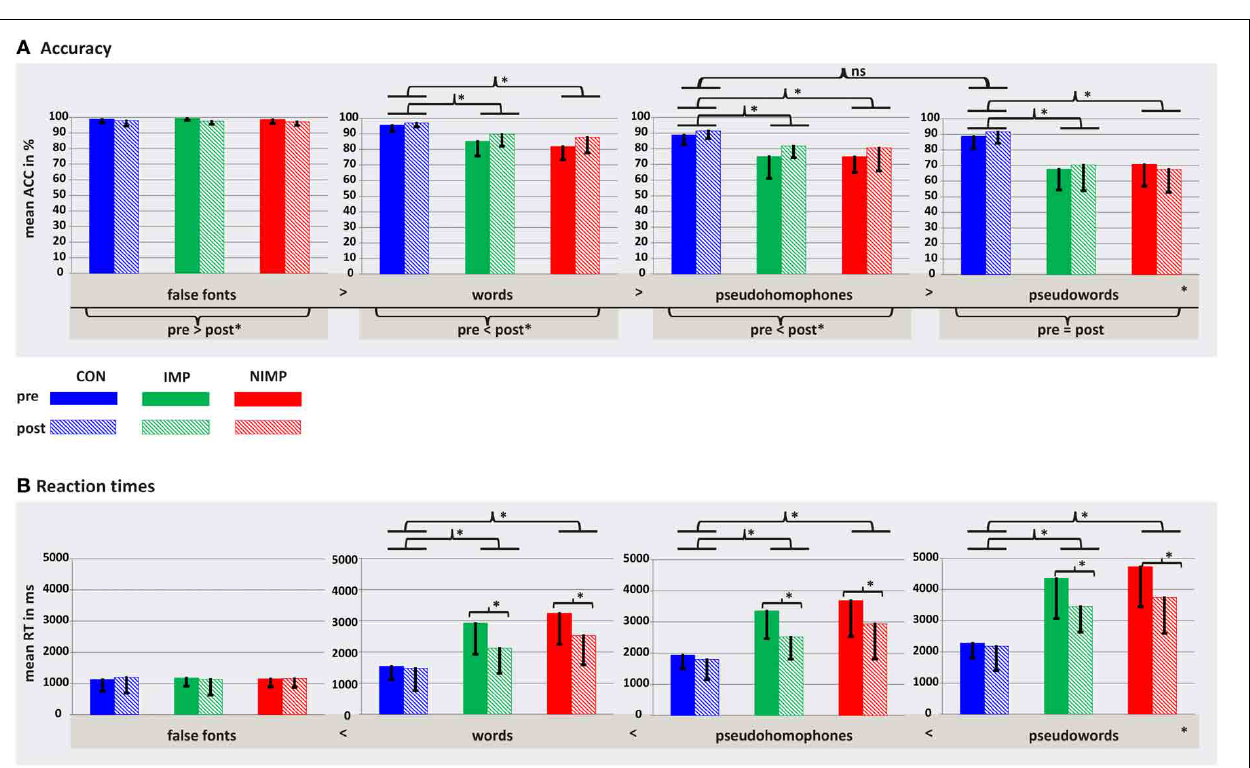
in common word reading fluency and N400 amplitudes.